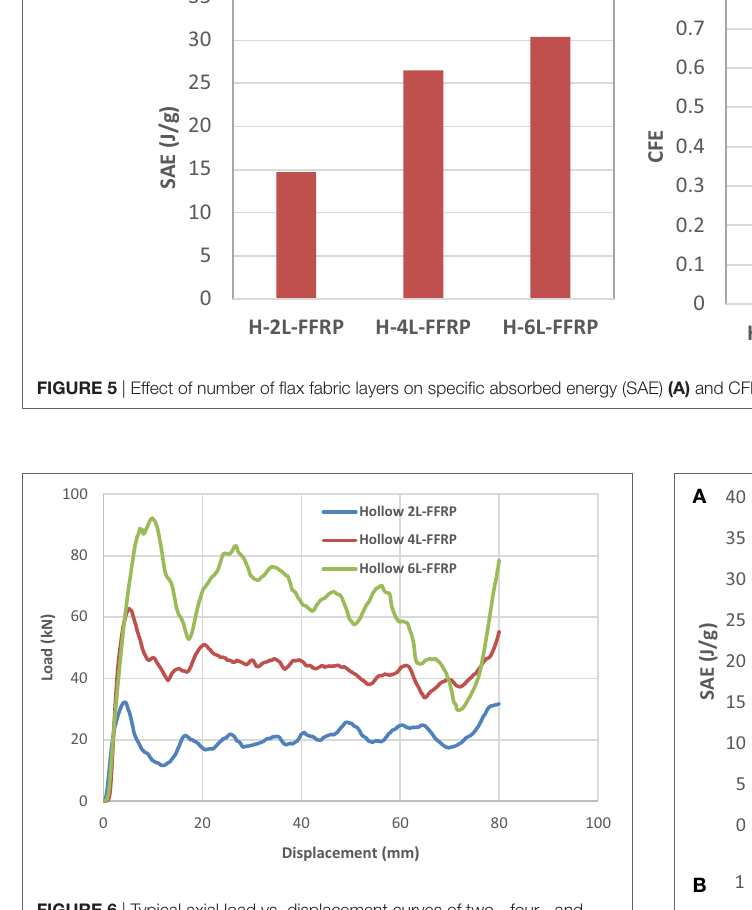
FigUre 6 | Typical axial load vs. displacement curves of two-, four-, and six-layer hollow flax FRP (FFRP) tubes.